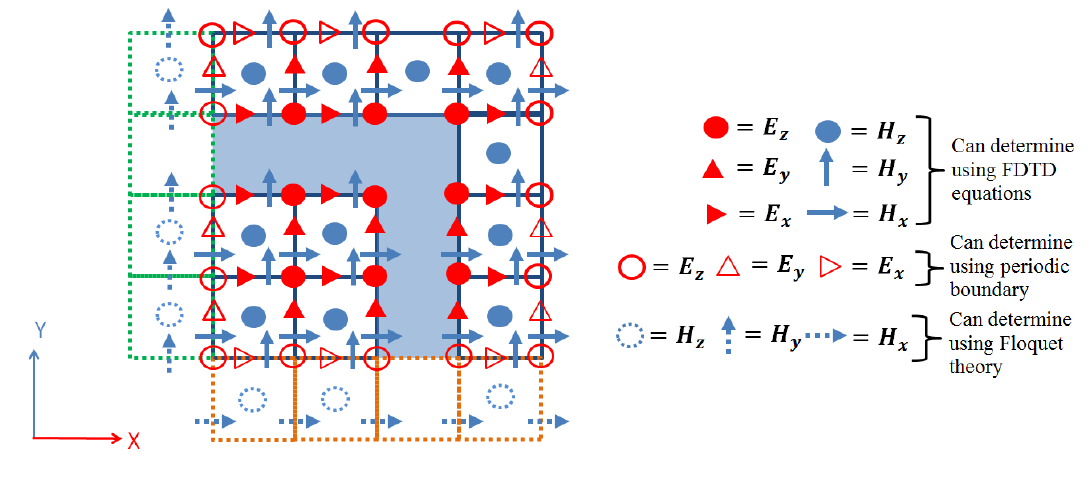
Figure 2. Field components in one unit cell.